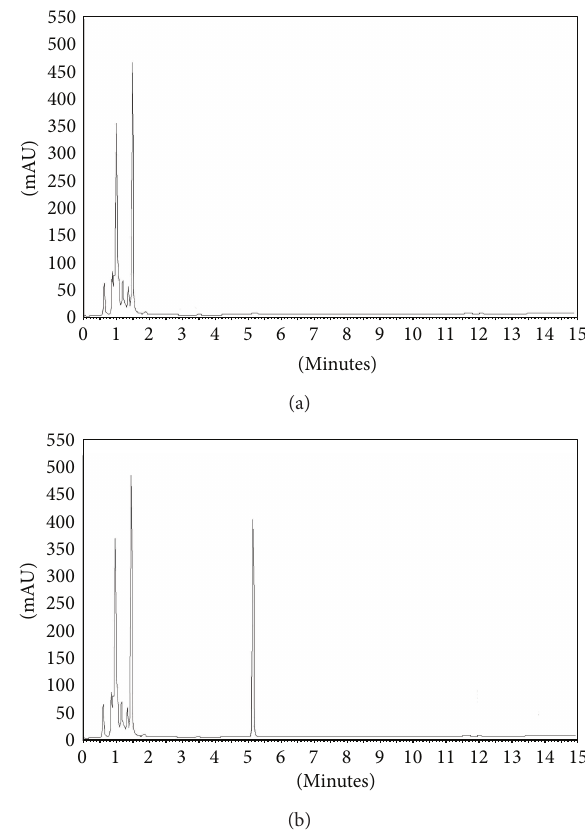
Figure 1: HPLC-DAD chromatogram (a) a blank dietary supple- ment and (b) of melamine (4.20 min) in validation sample (dietary supplement) spiked at